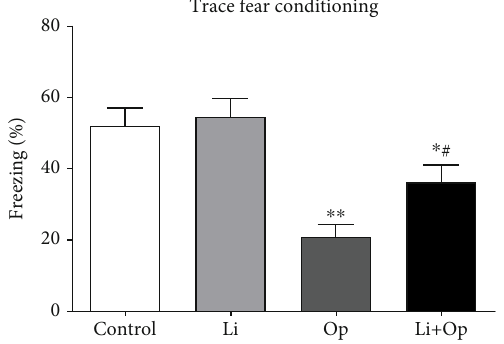
Figure 2: Inhibition of GSK-3 β alleviates tibial surgery-induced memory impairments. Contextual fear response, as measured by freezing behavior, was determined in the rats. The data are presented as means ± s : e : m : ( n = 6 rats). ∗ P < 0 : 05 and ∗∗ P < 0 : 01 compared with the control group. # P < 0 : 05 compared with the OP group.